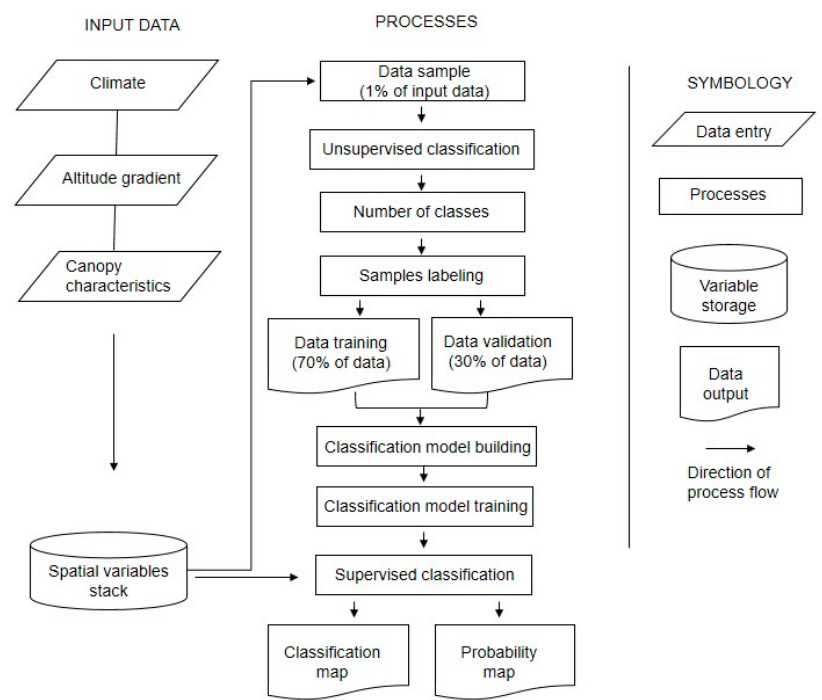
Figure 1. Map showing the locations of study areas: ( A ) “Sierra de Quila, Jalisco”; ( B ) “Sierra de Álvarez, San Luis Potosí,” and ( C ) “Selva El Ocote, Chiapas, México”.